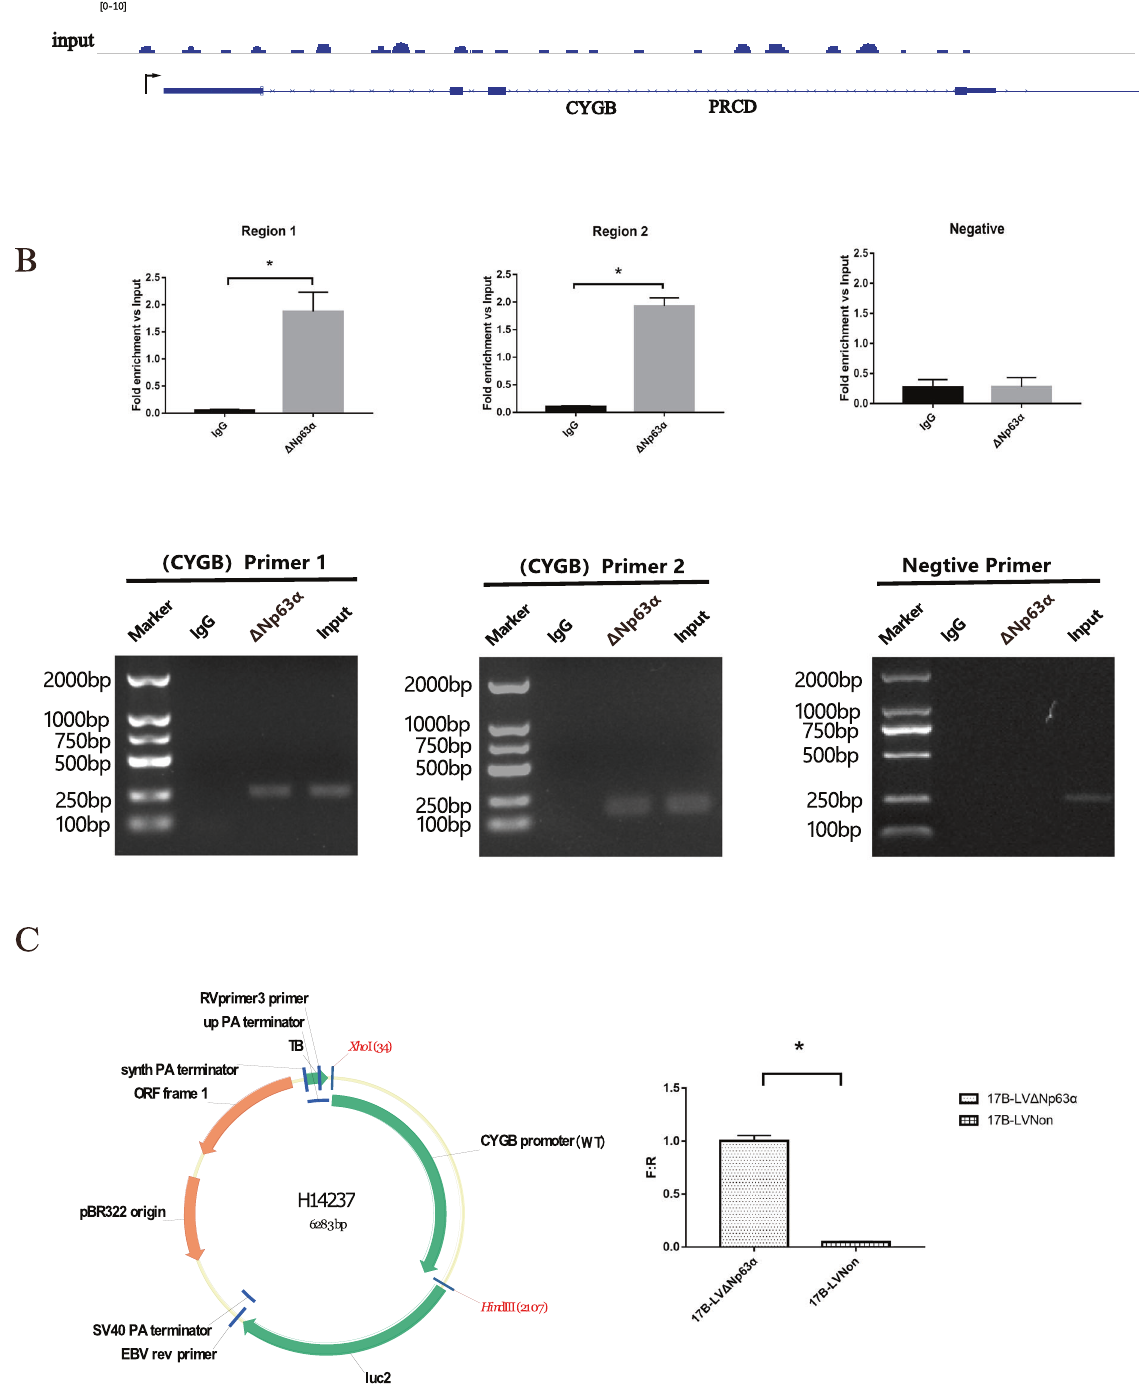
Fig. 8 CYGB is a direct transcriptional target of Δ Np63 α . A . ChIP analysis of the human regulatory region of CYGB was conducted by purifying chromatin from HN31 cells followed by immunoprecipitation with p63 α antibody. ChIP-seq was conducted to demonstrate Peak in Chromosome 17. B ChIP analysis of the regulatory region of CYGB was conducted by purifying chromatin from HN31 cells followed by immunoprecipitation with Δ Np63 antibody. * P < 0.01 C Lipo3000 was used to simultaneously transfect CYGB plasmid and renilla plasmid into 17B-Lv Δ Np63 α cells and 17B-LvNon cells. Fire fl y fl uorescent substrate and renilla fl uorescent substrate to detect the fl uorescence intensity, Fire fl y fl uorescent substrate and renilla fl uorescent substrate were mixed to detect the fl uorescence intensity. * P < 0.01.